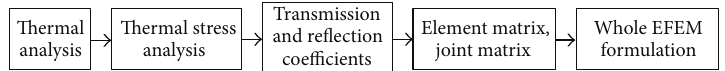
Figure 2: Energy distribution analysis process of coupled plates in nonuniform thermal environments.